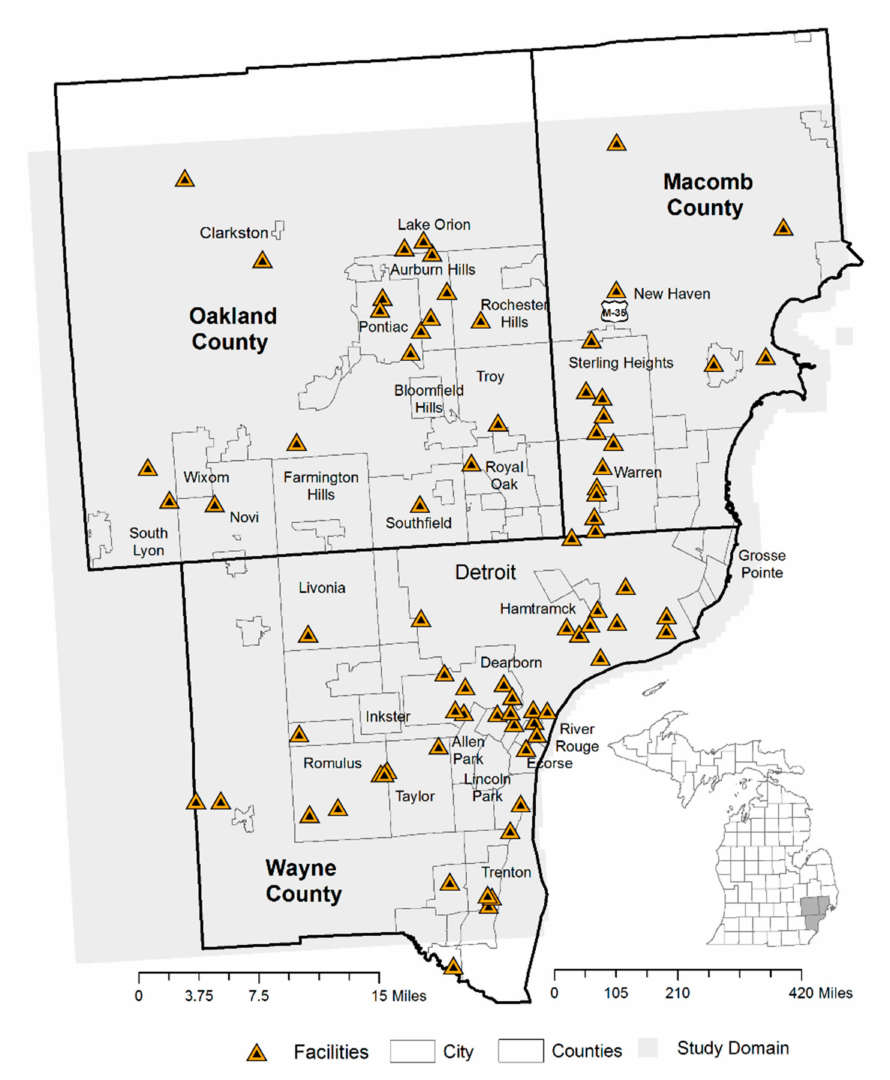
Figure 1. Reference map—locations of lead emitting facilities, AERMOD domain and city boundaries in the Detroit Metropolitan Area,